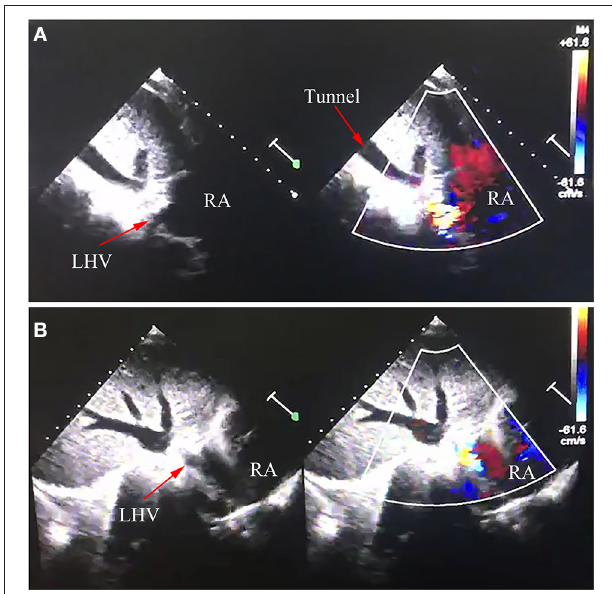
FIGURE 1 | Echocardiography image of anomalous left hepatic venous connection. LHV, left hepatic vein; RA, right atrium. (A,B) Echocardiography image confirmed LHV came into the RA.